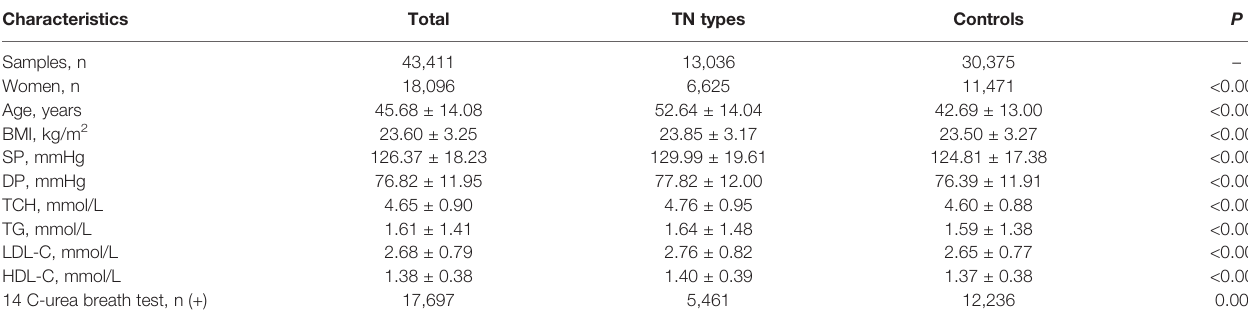
TABLE 1 | Participant